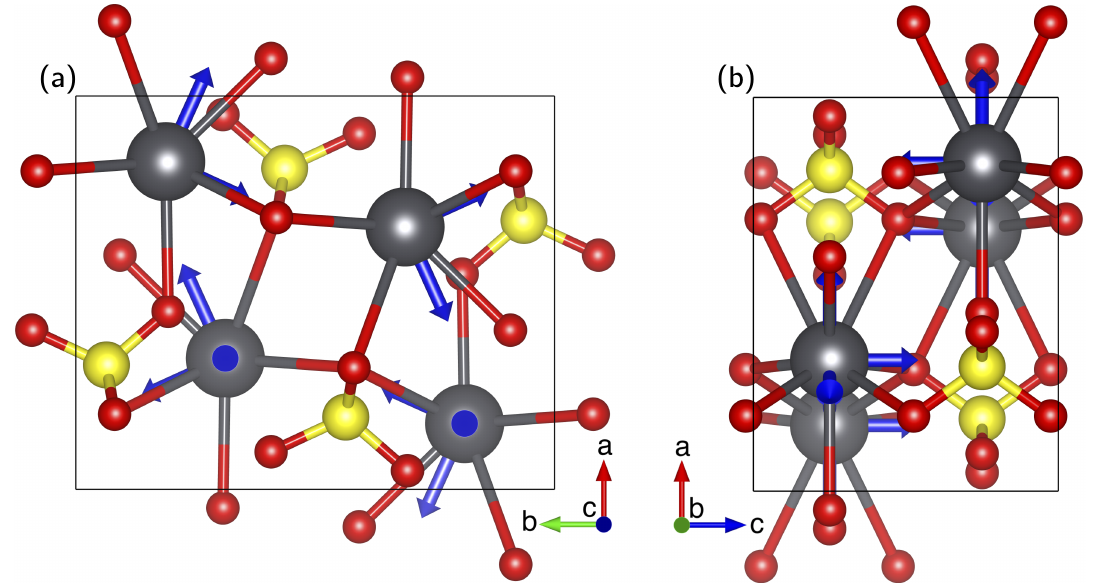
Figure 4. Orientation of the experimentally determined 207 Pb chemical-shift eigenvectors (blue) in the unit cell of anglesite, scaled according to the magnitude of the associated eigenvalues, such that an absolute value of 750 ppm corresponds to a length of 1 Å, with the lead atoms (gray) shown with their co-ordination to ten oxygen atoms (red): ( a ) View down the c axis; ( b ) view down the b axis. (Drawings generated with the V ESTA program